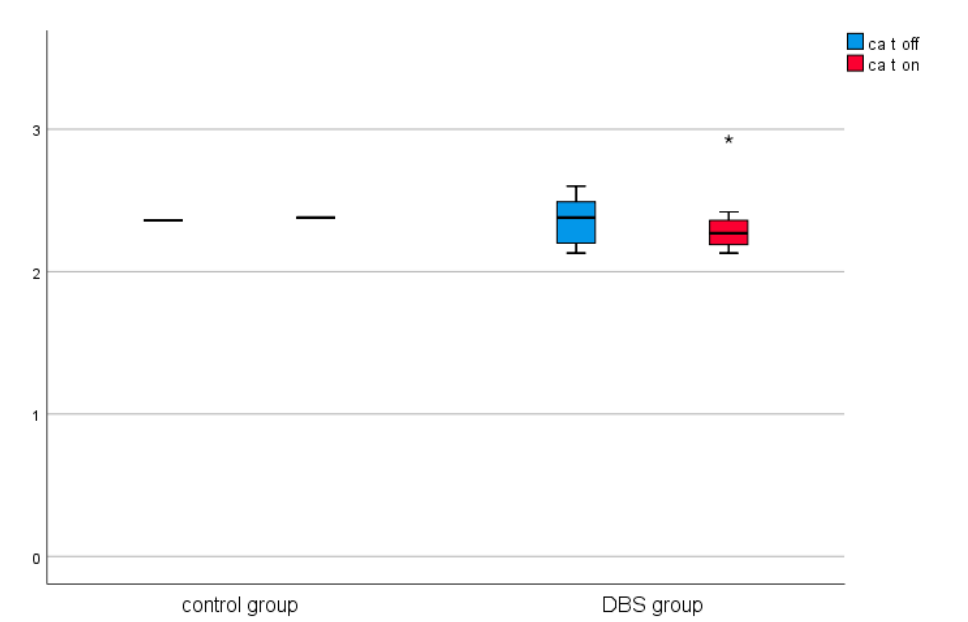
Figure 6. Effect of lesional surgery and DBS on calcium (mmol/L). (°—outliers ≦ 3SD, *—outliers > 3SD).